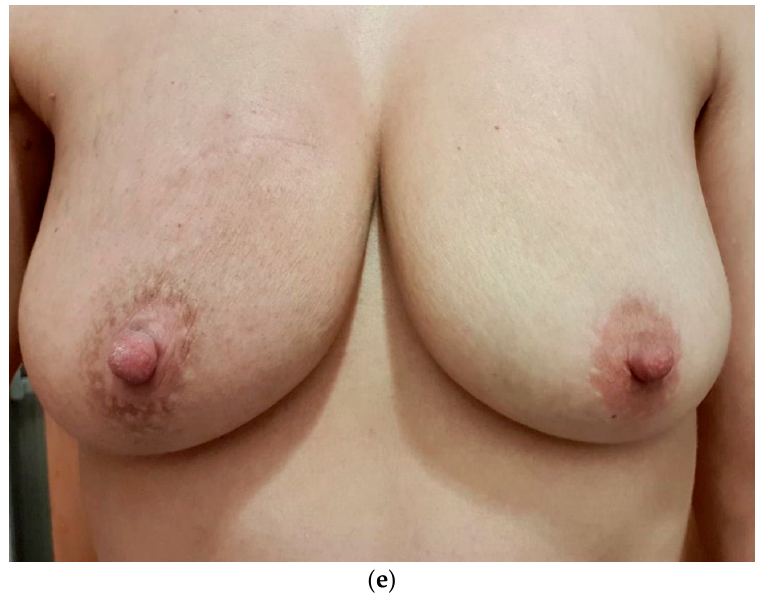
Figure 1. ( a ) Contrast-enhanced MRI of a 40-year-old woman with a 15 mm invasive breast cancer associated with non-mass enhancement (total footprint 60 mm) confirmed to be high grade DCIS on MRI-guided biopsy. The tumour was HER2 positive. ( b ) Pre-operative mammogram showing marker clip and SAVI SCOUT reflector. ( c ) Post-NST contrast-enhanced MRI showing excellent response of both invasive and DCIS components to paclitaxel, transtuzumab & pertuzumab, justifying de-escalation to BCS. ( d ) Intra-operative specimen mammogram showing radiological marker clip and SAVI SCOUT reflector centrally, with ligaclips for orienting circumferential margins. ( e ) Post- operative appearance following BCS and adjuvant radiotherapy. Mastectomy was avoided by the down-staging of DCIS by NST.